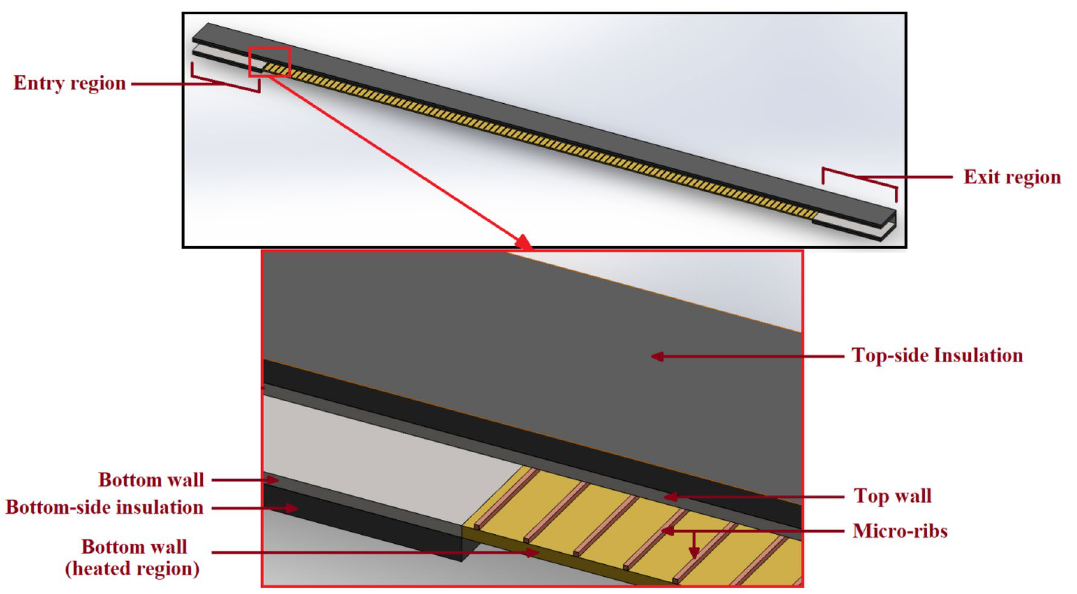
Fig. 2 Trimetric section view of the narrow channel